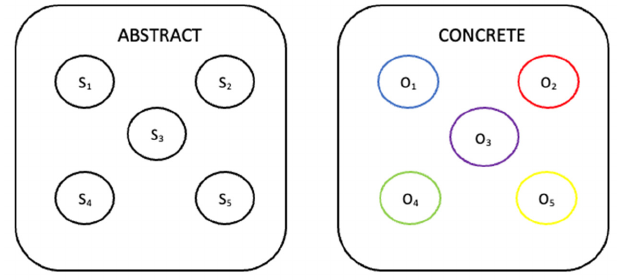
Figure 2. Ontological Structure: Pegboard (i).